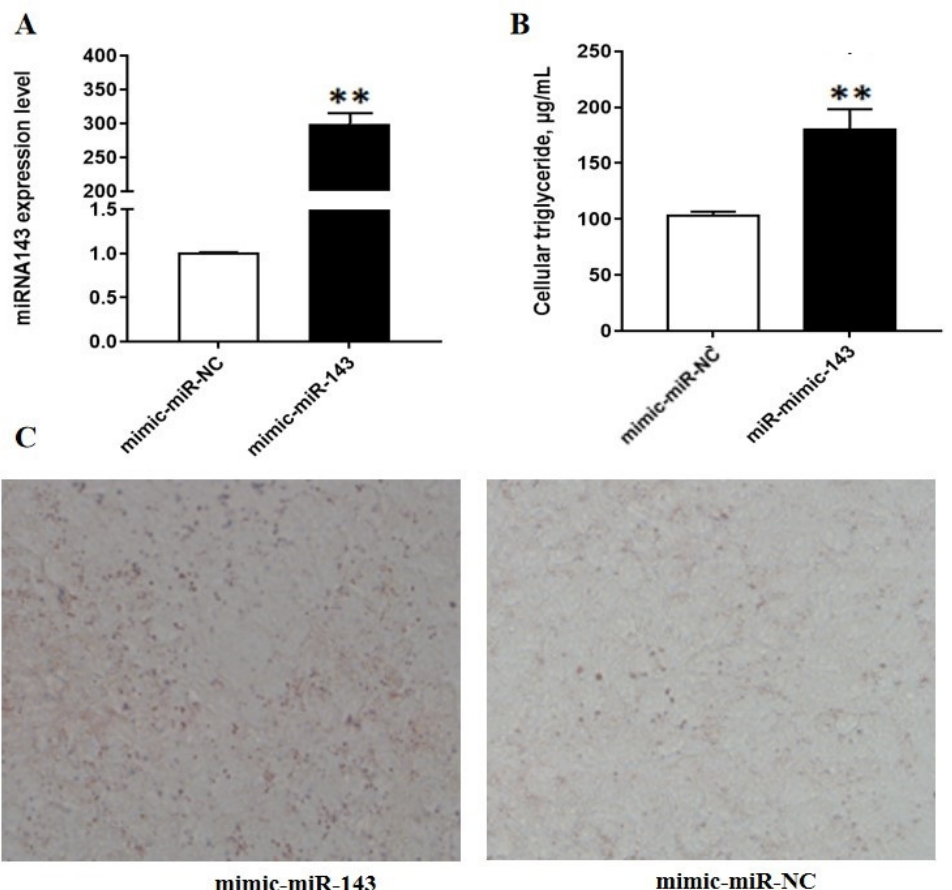
Figure 1. E ff ects of miR-143 mimic on milk fat synthesis. ( A ) miR-143 expression following miR-143 mimic treatment; ( B ) triglyceride levels in bovine mammary epithelial cells (BMECs) after treatment with the miR-143 mimic; ( C ) alteration in the number of lipid droplet in BMECs following miR-143 mimic treatment. ** p < 0.01.